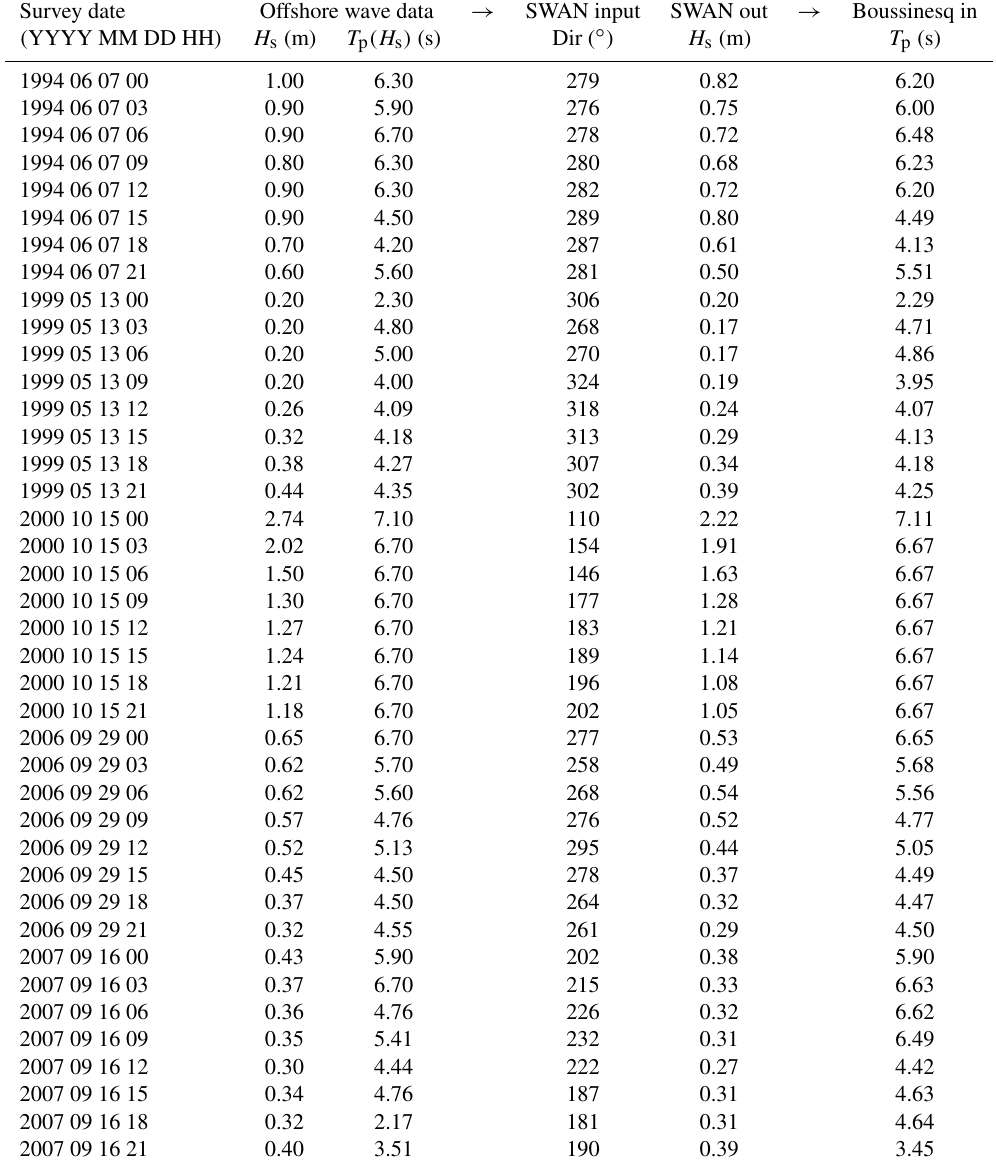
Table 4. Data and results of the simulations relating to the five aerial surveys: day considered for wave data processing, offshore wave data used as input for SWAN, and SWAN output used as Boussinesq-model input.